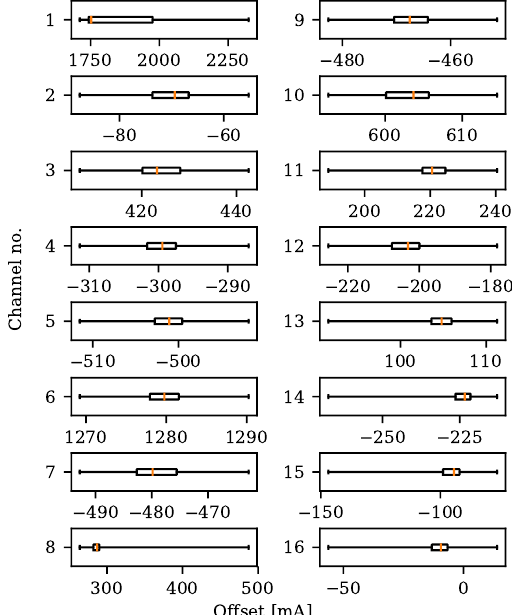
Figure 2. Offset study in a 168 h zero current situation. The red trace corresponds to the average offset; the box corresponds to three quartiles of the data; and the whiskers bar corresponds to the full channel data